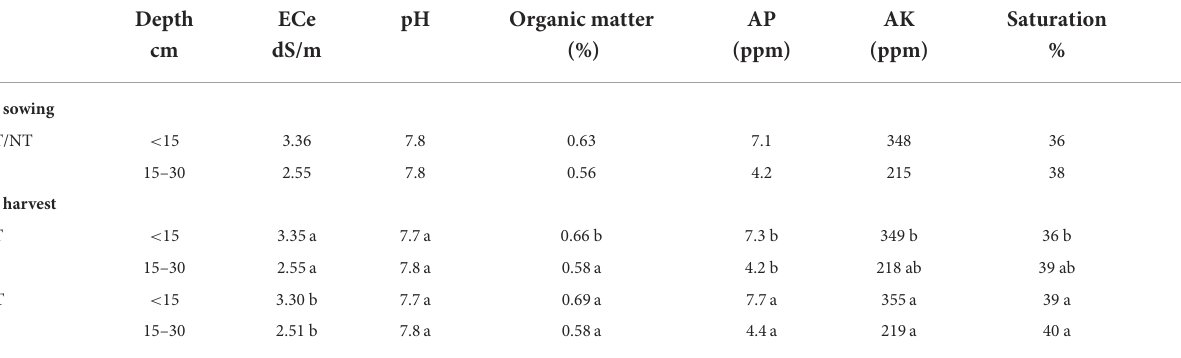
TABLE 1 Soil physicochemical properties of the experimental site at cotton sowing and harvest under conventional tillage (CT) and no-tillage (NT)